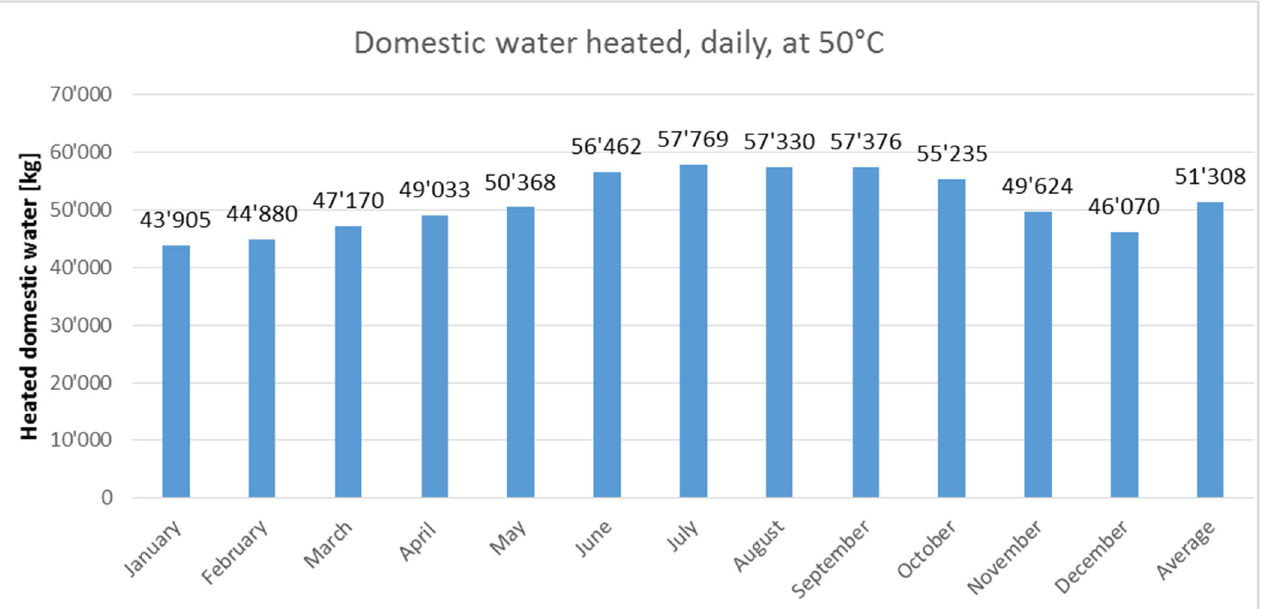
Figure 10. Average heating energy daily available at the plate condenser, expressed in kWh/day.